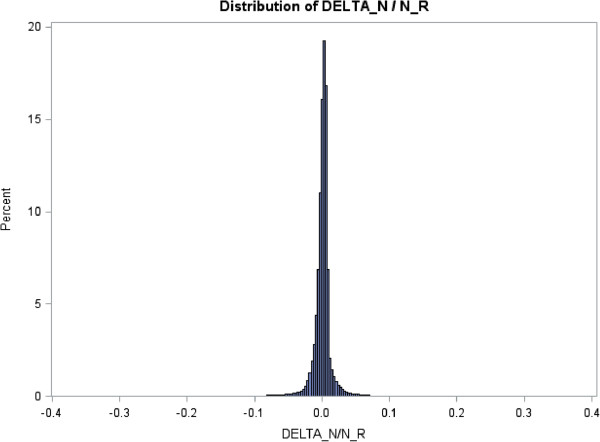
Distributions of Δ
N 
/ N
R 
withΔN=N^R−NR, whereN^Ris the number of subjects per group predicted by the linear regression model
and N
R 
is the number of subjects per group associated with the Raschpower method.